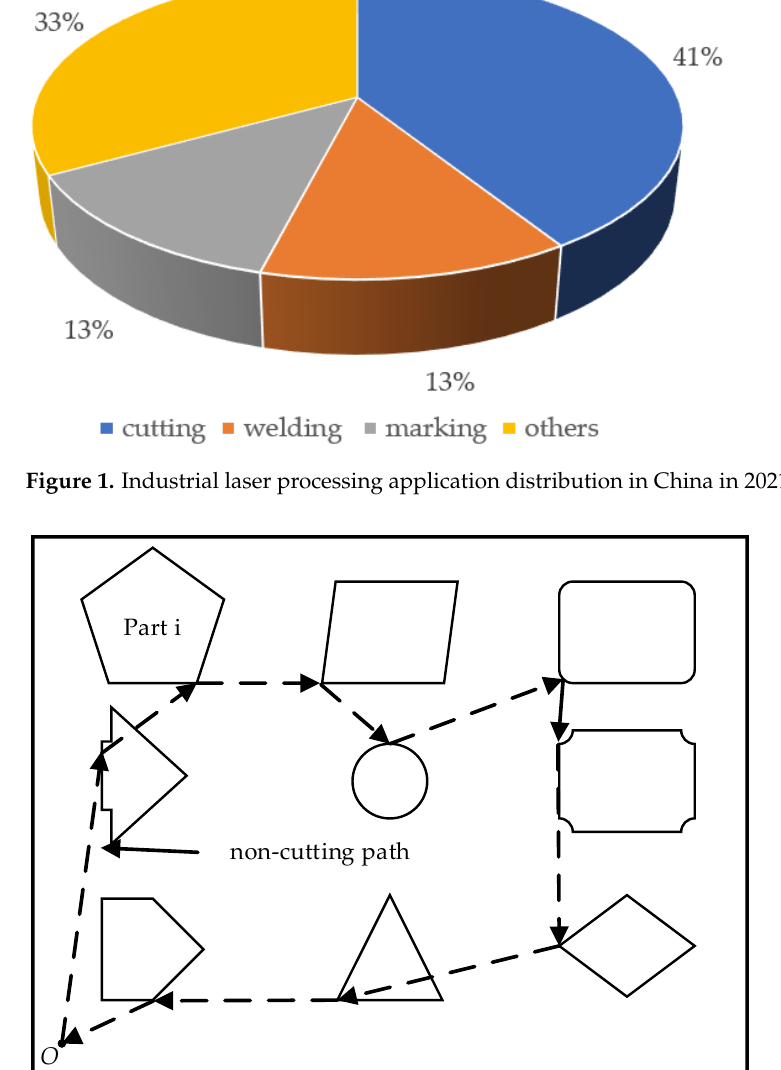
Figure 1. Industrial laser processing application distribution in China in 2021.